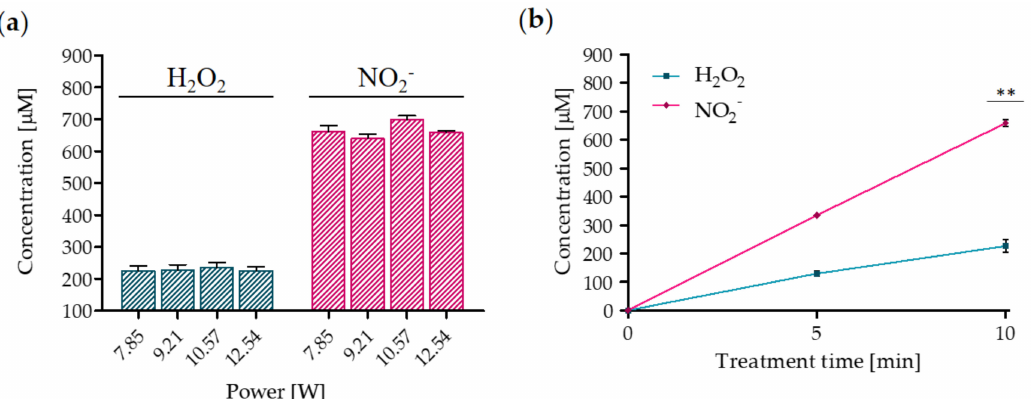
Figure 2. Plasma treatment leads to the formation of H 2 O 2 and NO 2 − . ( a ) Reactive oxygen and nitrogen species (RONS) concentration as a function of the average power after 10 min of plasma treatment. Data are presented as mean ± SEM ( n = 3). ( b ) H 2 O 2 and NO 2 − concentrations as a function of treatment time. Data are presented as mean ± SEM ( n = 3) and statistical significance is specified with asterisks (** p ≤ 0.001 as determined by a paired Student’s t -test, versus the 5 min